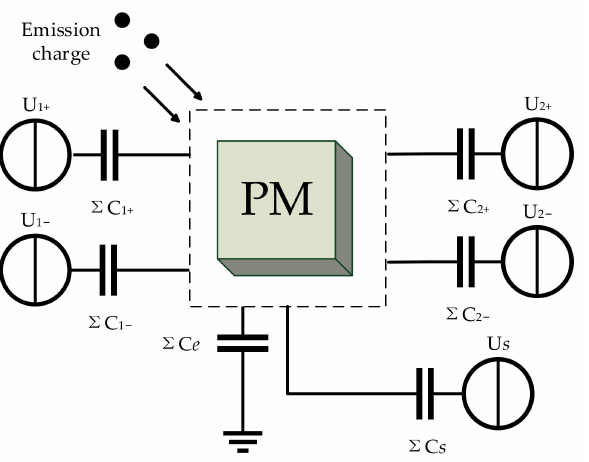
Figure 2. Capacitor model of ESA in single axis. Capacitances with the same subscript number are equal to each other. Where U j is the actuation voltage applied on the electrode, C j is the actuation capacitance, U s is the excitation voltage for sensing, C s is the sensing capacitance, C e is the coefficient of capacitances between the mass and the grounding